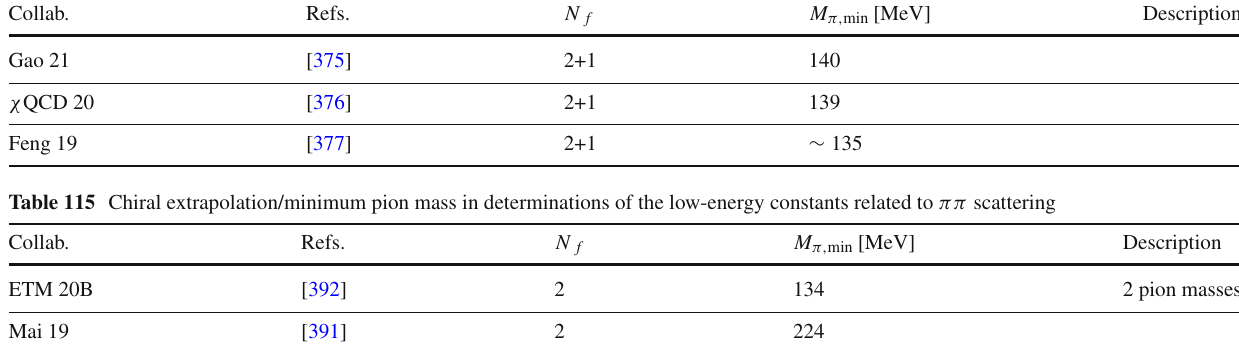
Table 114 Chiral extrapolation/minimum pion mass in determinations of the low-energy constants related to the vector form factor of the pion Collab.